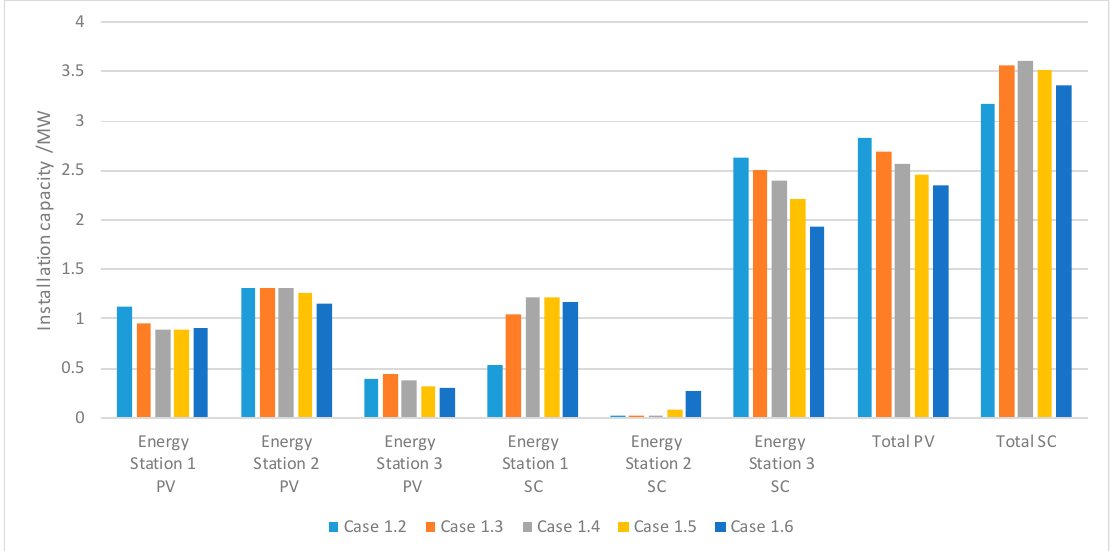
Figure 4. Analysis of the accommodation capacity under different irradiance fluctuation ranges.